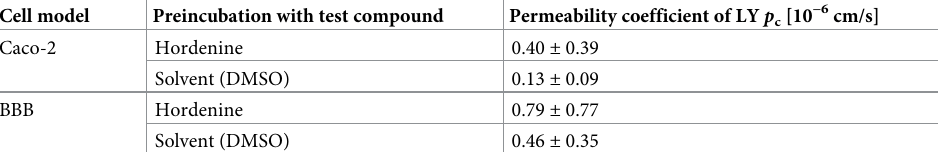
Table 1. Permeability coefficients of Lucifer Yellow (LY) after 48 h preincubation with hordenine (1 μ M) and sol- vent (0.1% DMSO) ( n = 3 ×